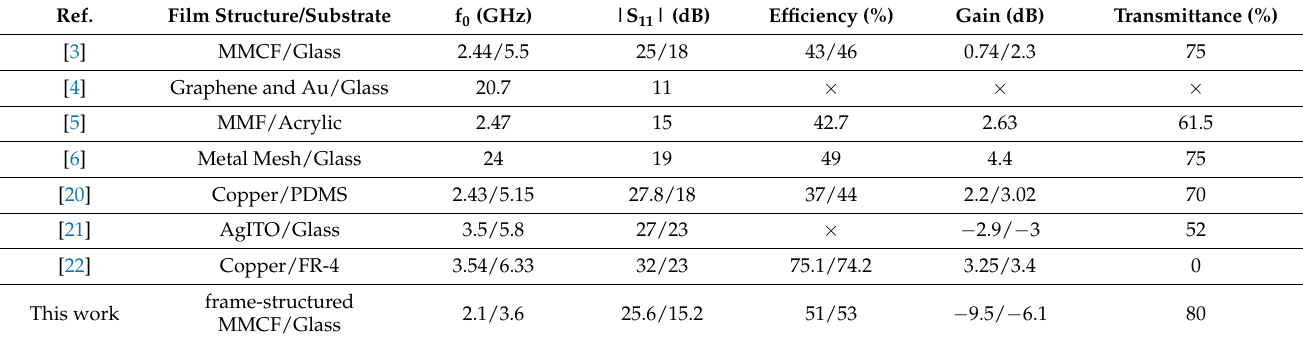
Table 1. Performance comparison of this study with other previous transparent antenna references. Ref.